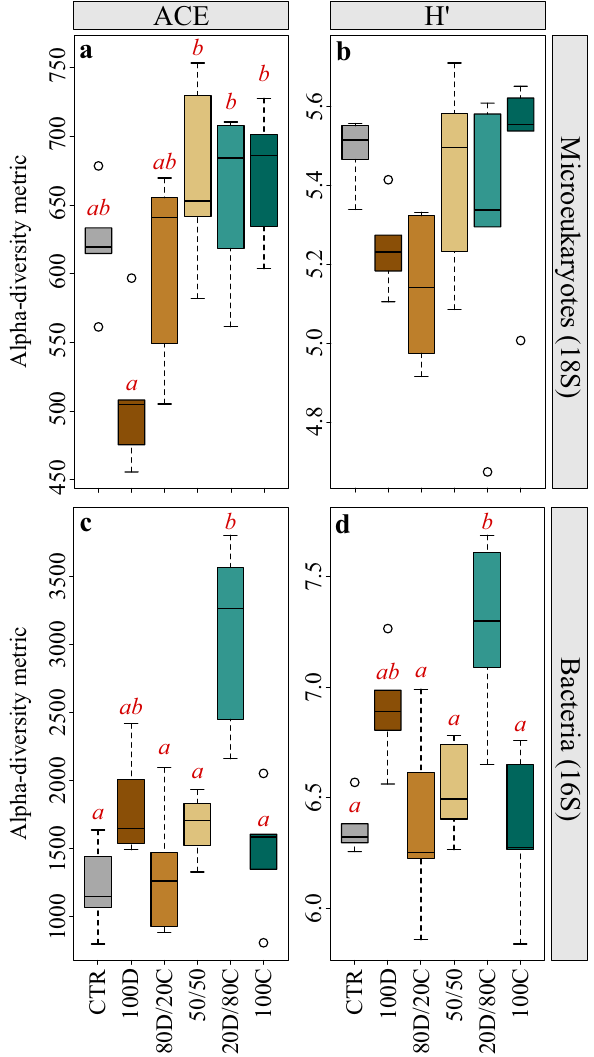
Figure 2. Alpha diversity indices (Abundance-based coverage estimator (ACE) and Shannon’s diversity index H ′ ) for ( a , b ) microeukaryotes and ( c , d ) bacteria upon experiment termination. Red letter codes designate the significant differences across treatments based on one-way ANOVA and TukeyHSD post-hoc test results. See Fig. 6 for labels on the